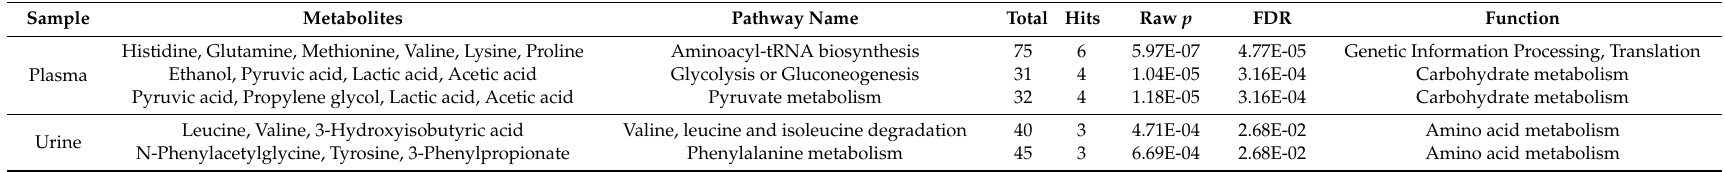
Table 3. Metabolic pathway and function analysis of metabolites associated with allergic sensitization for childhood